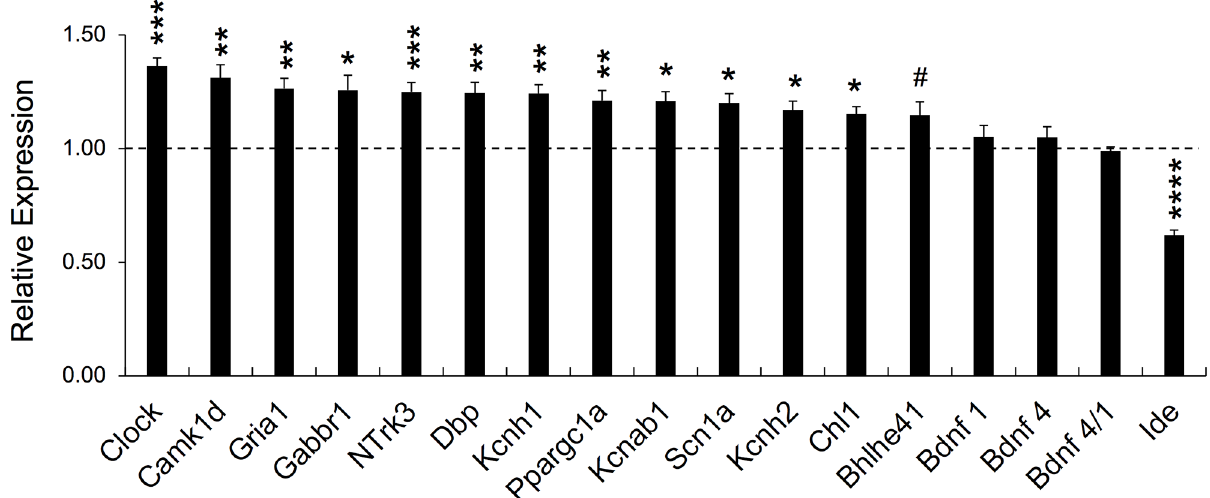
Fig 6. Ide is downregulated in Bhlhe40 KO hippocampus. For validation, messenger RNA (mRNA) levels were determined by Quantitative Reverse Transcription Polymerase Chain Reaction (qRT-PCR). Messenger RNA from WT (n = 8) and Bhlhe40 KO (n = 8) mice were extracted from hippocampal tissue. Messenger RNA levels for genes in Bhlhe40 KO mice are expressed relative to WT (100% = dashed line). Specific mRNA levels within samples were normalized to the housekeeping gene Hprt . Bdnf 4 was additionally tested relative to Bdnf 1 ( Bdnf 4/1 ).Unpaired t-tests were used to test for significance for each gene; (cid:3) = p < 0.05, (cid:3)(cid:3) p < 0.01, (cid:3)(cid:3)(cid:3) = p < 0.001, (cid:3)(cid:3)(cid:3)(cid:3) = p < 0.0001 (S1 Table for all genes tested); WT n = 8, Bhlhe40 KO n = 8; Error bars are standard error of the mean. All error bars are standard error of the mean.